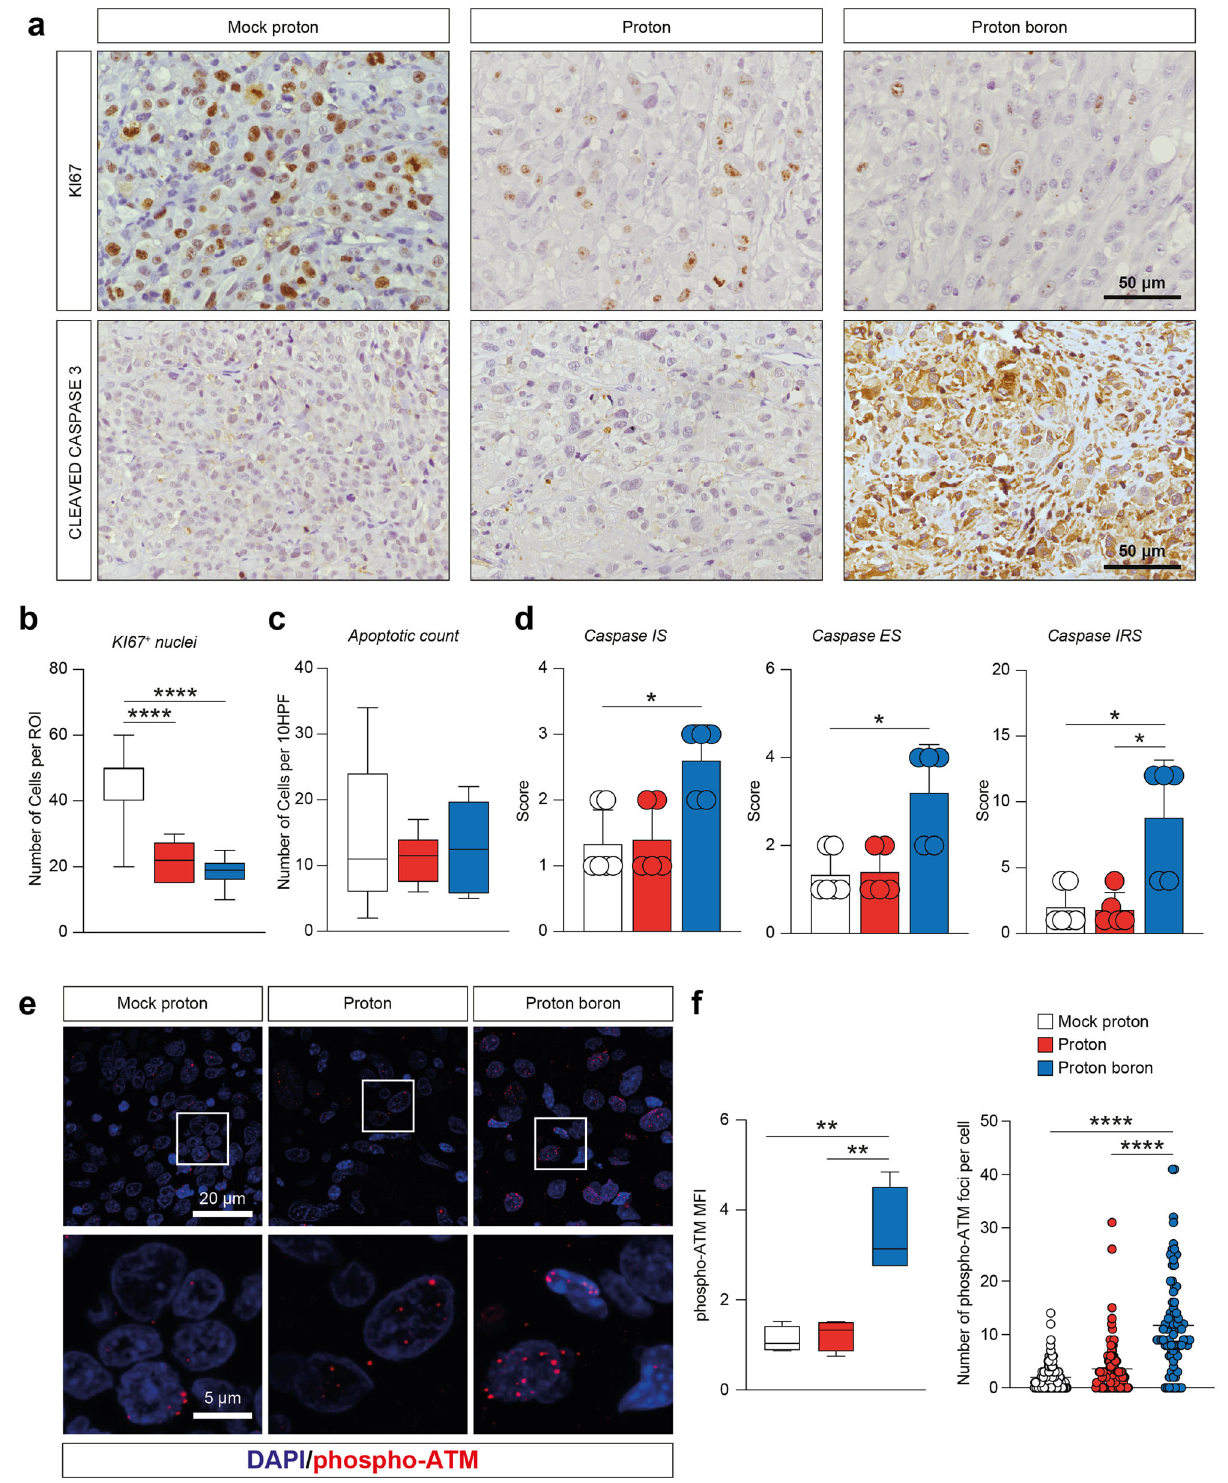
Fig. 3 Proton boron capture therapy induces similar cell death effects as compared to proton irradiation but a higher caspases signal. a Representative images of KI67 nuclei and caspases in GBM tumor sections derived from mock proton, proton-treated and proton boron-treated mice. b – d Quanti fi cation of KI67 positive cells, apoptotic count, and percentage of immunopositivity cells for caspases in GBM tumor sections derived from mock proton (white boxes and white circles), proton-treated (red boxes and red circles) and proton boron-treated (blue boxes and blue circles) mice. e , f Representative pictures and quanti fi cation of the MFI and number of foci per cell of phospho-ATM staining in mock proton (white boxes and white circles), proton-treated (red boxes and red circles) and proton boron-treated (blue boxes and blue circles) mice. Nuclei are stained with DAPI. * p -value < 0.05, ** p -value < 0.01 and **** p - value < 0.0001. IS Intensity score, ES Extent Score, IRS intensity reactivity score, MFI mean fl uorescence intensity.